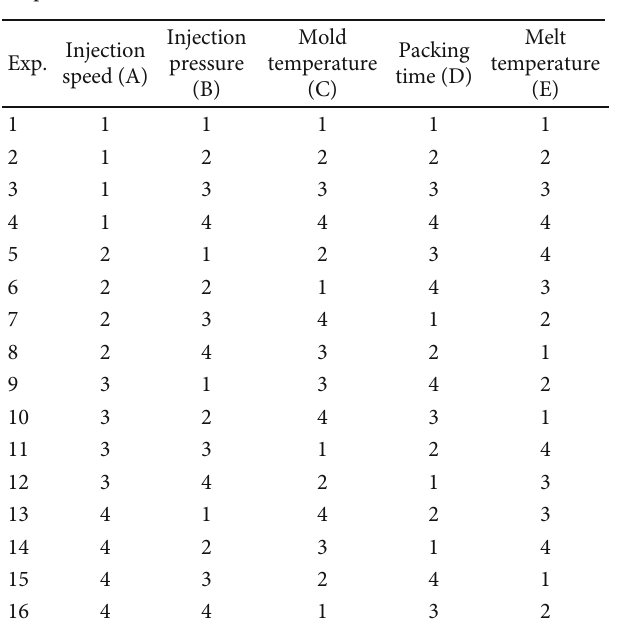
orthogonal array used in the main experiment